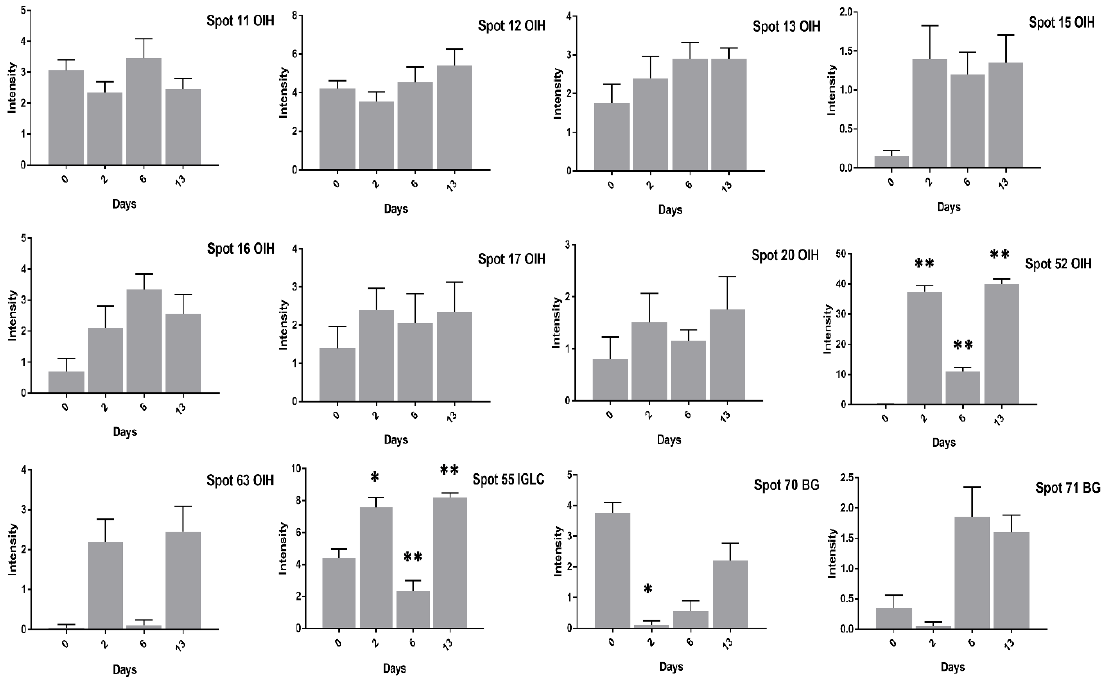
Figure 10. Changes in the intensity of OIH, IGLC and BG proteins spots after 0, 2, 6, and 13 days of incubation was shown in low cholesterol eggs. The column profiles of these proteins are indicated as bar charts with significant differences. The values are from three independent replicates and the error bars represent the standard deviation. * p < 0.05, ** p < 0.005.